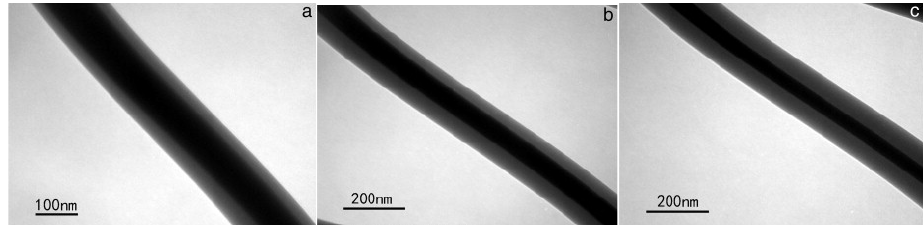
Figure 4. TEM images of PVA/CH core–shell composite nanofibers with different feed ratios of ( a